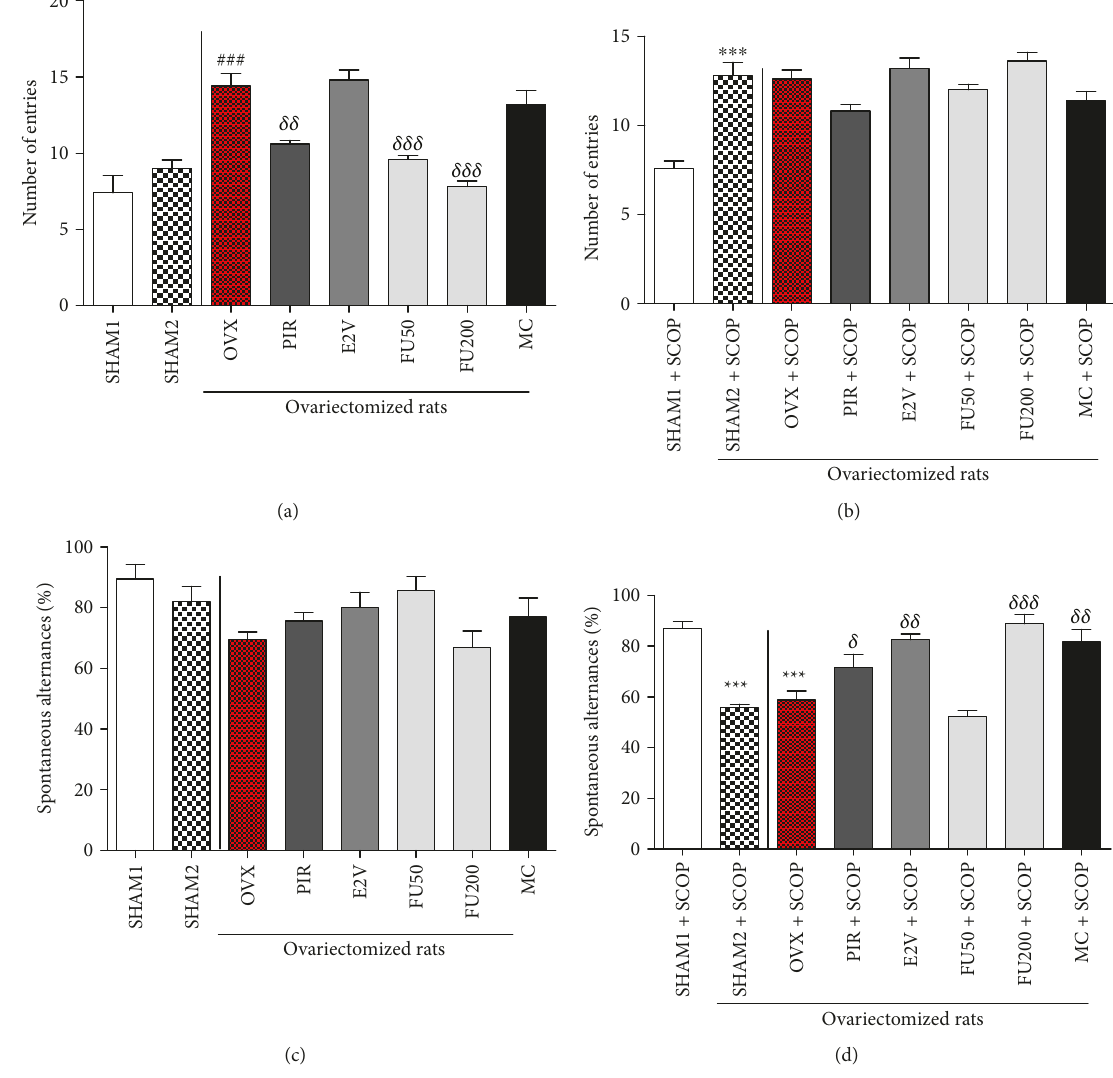
Figure 4: Graphic representation of the number of entries (a and b) and percentage of spontaneous alternances (c and d) before and after scopolamine exposition in rats treated with di ff erent substances into the Y-maze. SHAM 1 =sham-operated rats treated with vehicle as normal control 1; SHAM 2=sham-operated rats treated with vehicle as normal control 2; OVX =ovariectomized rats treated with vehicle as negative control; PIR=ovariectomized rats treated with piracetam at the dose of 1.5 mg/kg BW as positive control 1; E2V=ovariectomized rats treated with estradiol valerate at the dose of 1mg/kg BW as positive control 2; FU 50 and 200=ovariectomized rats treated with F. umbellata aqueous extract at the doses of 50 and 200 mg/kg BW, respectively; MC=ovariectomized rats treated with 7-methoxycoumarin at the dose of 1 mg/kg BW. SCOP =animal that received a single dose of scopolamine (2 mg/kg BW). ∗∗∗ p < 0 001 as compared to the SHAM 1 group; ### p < 0 001 as compared to the SHAM 2 group; δ p < 0 01 , δδ p < 0 01 , and δδδ p < 0 001 as compared to the OVX